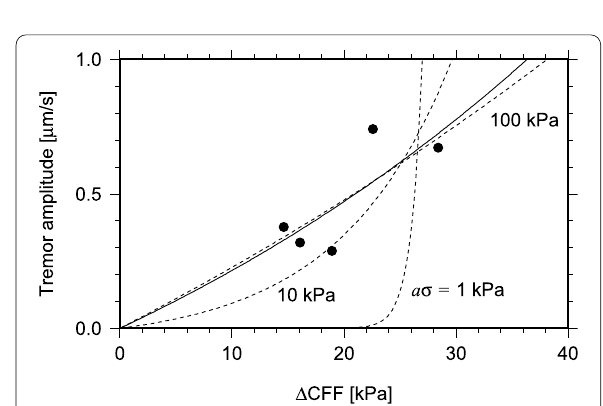
Fig. 5 Relationship between the peak velocity amplitude of the triggered tremor and the peak Coulomb failure stress changes. The slid line represents the regression fit with aσ lines represent the theoretical relationship for aσ